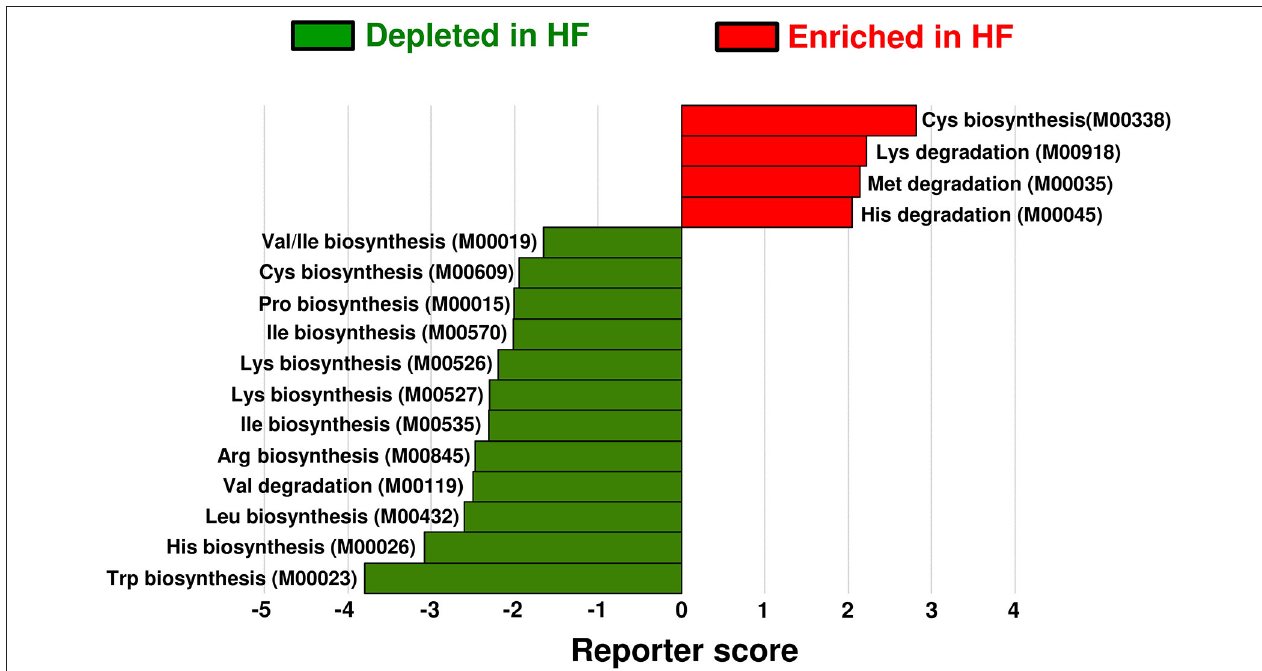
FIGURE 4 | Functional alterations in gut microbial amino acid metabolism among patients with heart failure (HF). Differentially enriched Kyoto Encyclopedia of Genes and Genomes (KEGG) orthology modules in amino acid metabolism between patients with HF ( n patients with HF and controls are indicated with positive reporter scores (red) and negative reporter scores (green), respectively. Arg, arginine; Cys, cysteine;